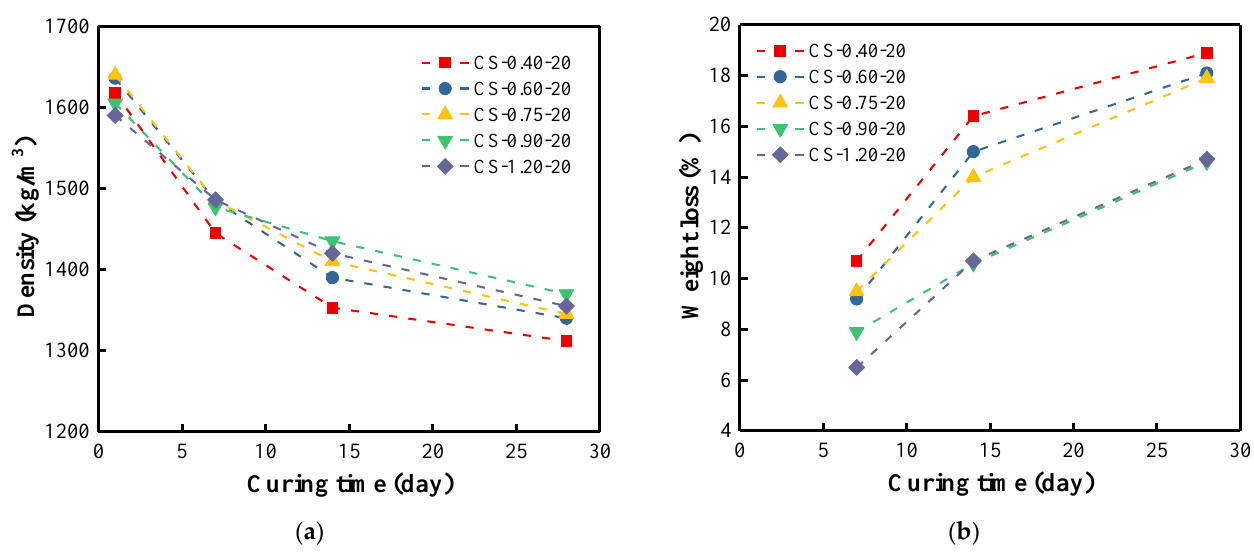
Figure 11. ( a ) Density of BFA-based AAM pastes cured at 20 °C for 28 days; ( b ) weight loss of samples in % during 28 days.